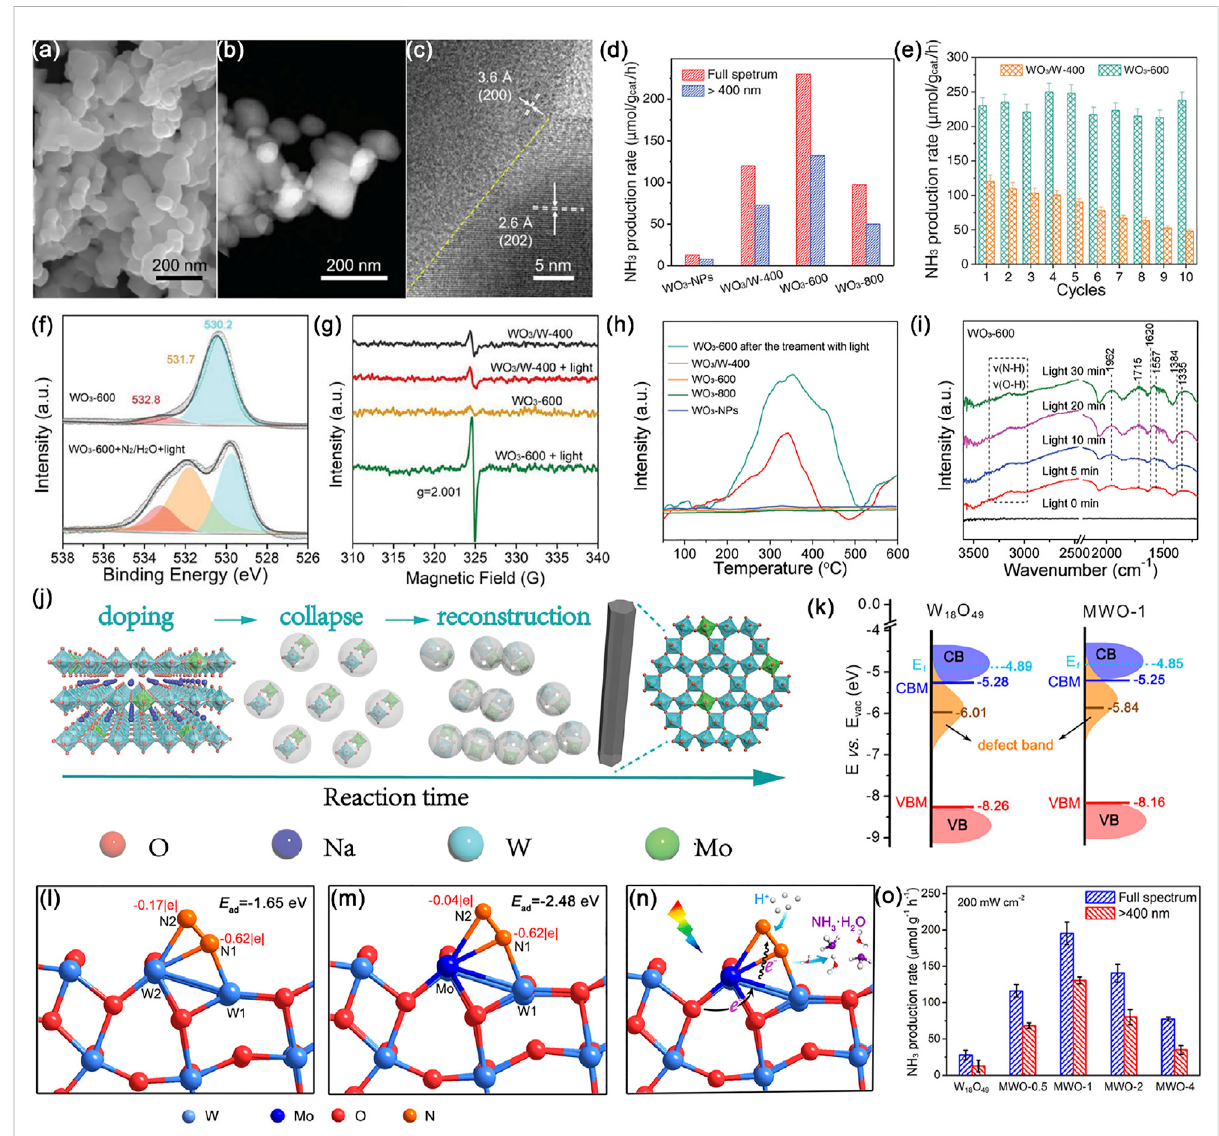
FIGURE 5 (A) Scanning electron microscopy (SEM) image, (B) high-angle annular dark- fi eld scanning transmission electron microscopy (HAADF-STEM) image, and (C) high-resolution TEM (HRTEM) image of WO 3 -600. (D) Photocatalytic NH 3 production rates over WO 3 -NPs, WO 3 /W-400, WO 3 -600, and WO 3 -800. (E) NH 3 production rates for WO 3 -600 and WO 3 /W-400 over the course of ten rounds of successive reactions. (F) Quasi in situ XPS spectra of O 1s in WO 3 -600 before and after treatment. (G) In situ ESR spectra of WO 3 /W-400 and WO 3 -600 before and after light irradiation.